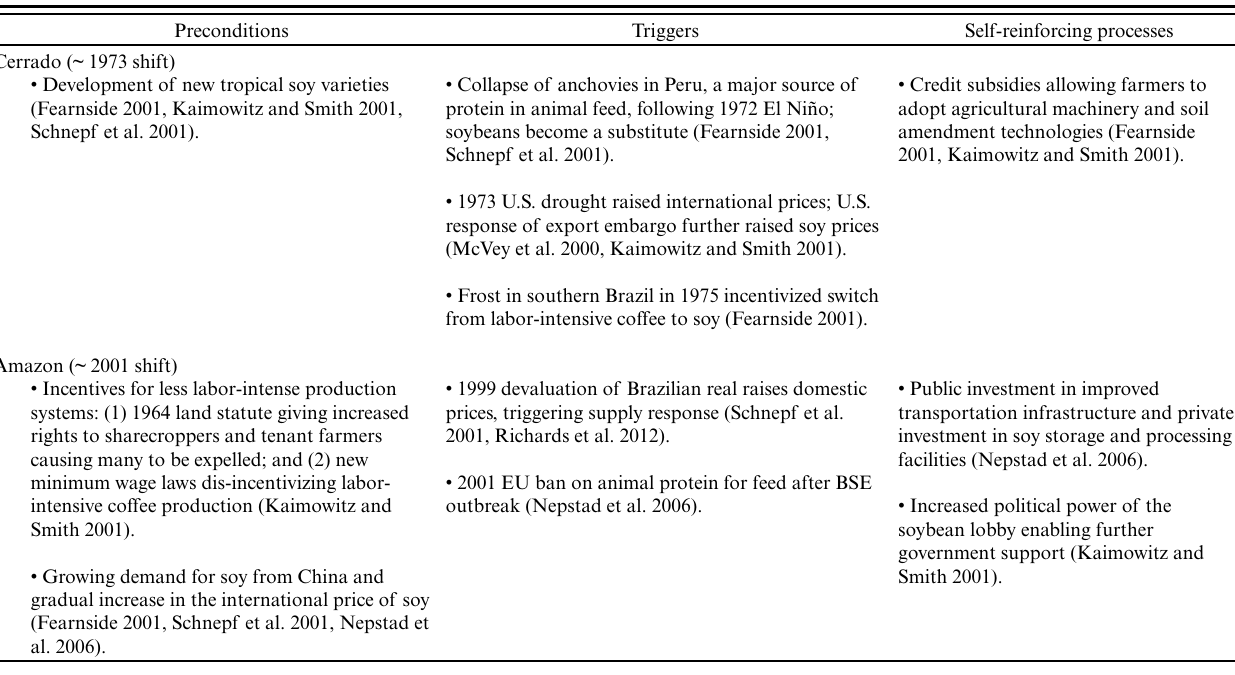
Table 1 . Preconditions, triggers, and self-reinforcing processes for a regime shift from small-scale agriculture (Cerrado ~1973) or cattle ranching (Amazon ~2001) to soy in Brazil.